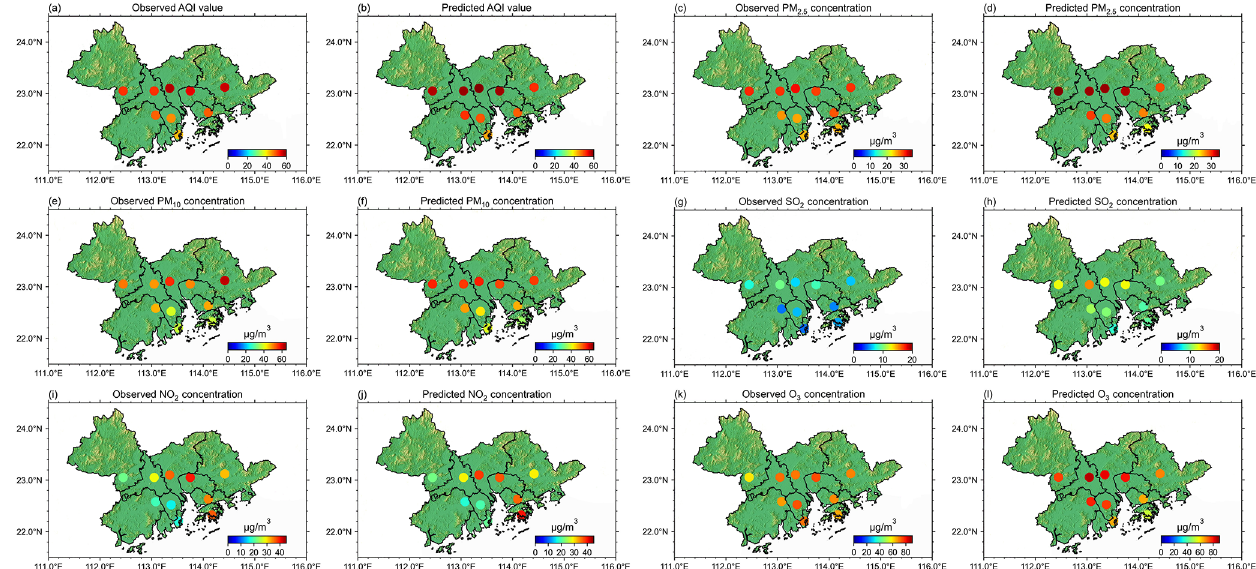
Figure 8. The spatial distribution of AQI and five pollutants during Typhoon Danas. Observed and predicted (a–b) AQI value, (c–d) PM 2 . 5 , (e–f) PM 10 , (g–h) SO 2 , (i–j) NO 2 and (k–l) O 3